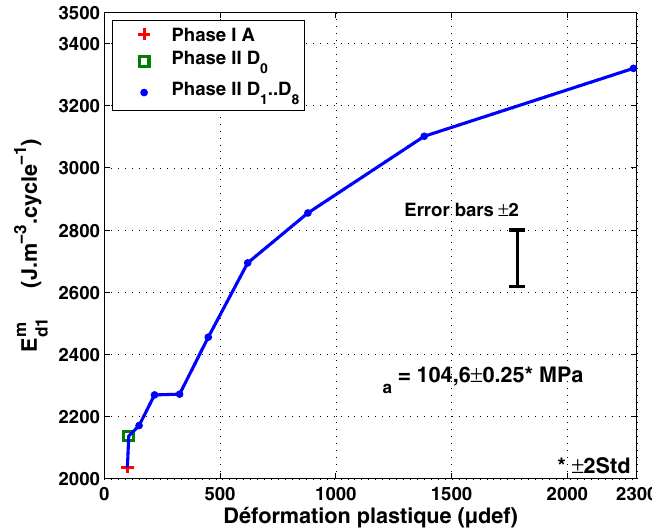
Fig. 4. Dissipative energy measurement E m